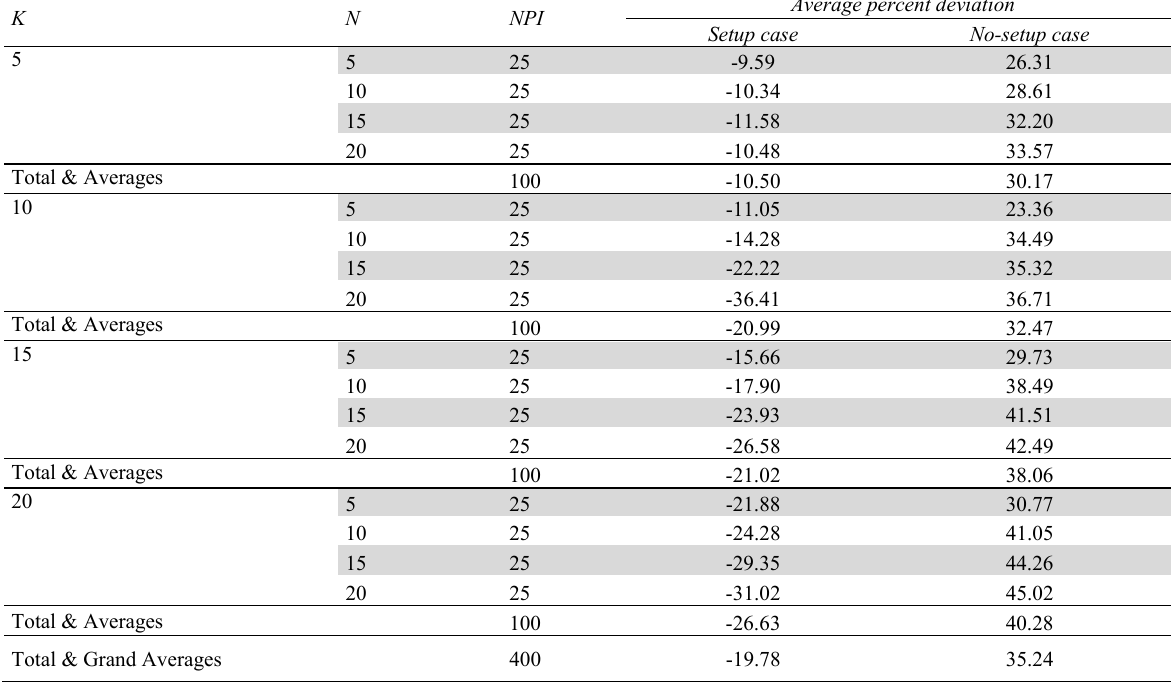
Comparison of the job-based and order-based processing